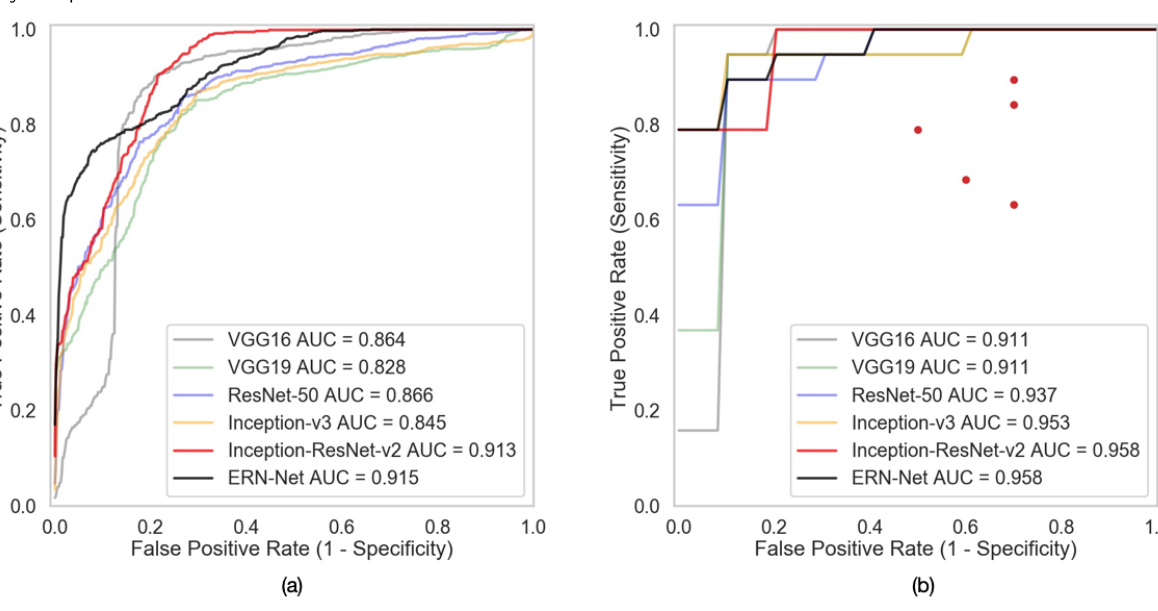
Figure 4. Plots showing (a) performance of the deep neural network (DNN) models on multimodal magnetic resonance imaging in the image-based classification task and (b) performance of the DNN models and neurosurgeons in the subject-based classification task. Performance of the DNN models was evaluated using the area under the curve (AUC) of the receiver operating characteristic curves, while the five neurosurgeons’ sensitivity and specificity scores are represented by the red dots. ERN-Net: efficient radionecrosis neural network; ResNet: residual neural network; VGG: Visual Geometry